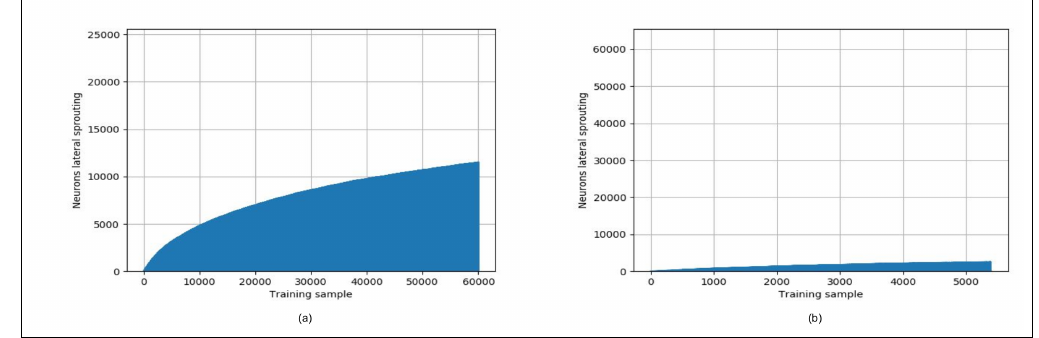
Figure 5. SOMs lateral sprouting in the multimodal association process: ( a ) Written/Spoken digits maps; ( b ) DVS/EMG hand gestures maps. We notice that less than half of the possible lateral connections are created at the end of the Hebbian-like learning, because only meaningful connections between correlated neurons are created. For ( b ), the even smaller number of connections is also related to the small size of the training dataset.